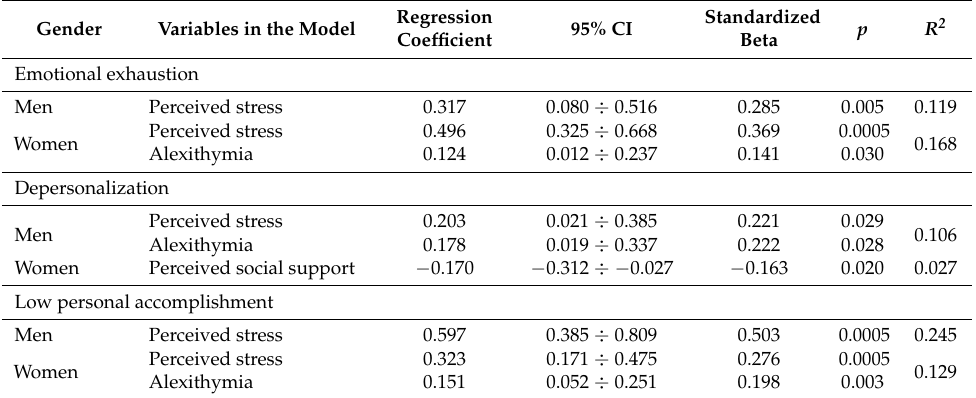
Table 3. Predictors of burnout components (hierarchical multiple backward regression)